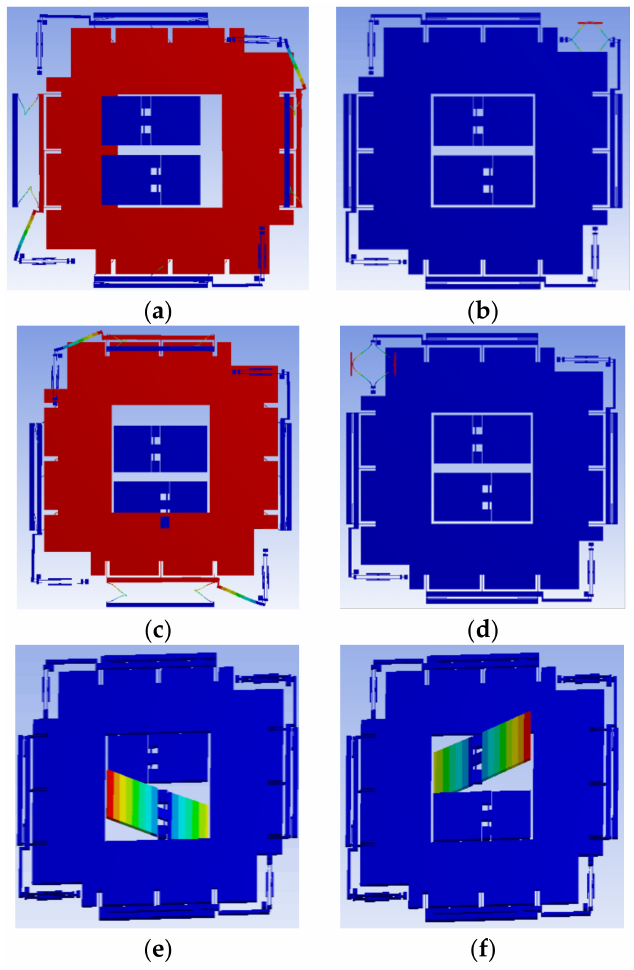
Figure 3. Vibration modal simulation of three-axis acceleration. ( a ) 1 kHz vibration of the mass in the x-axis; ( b ) 20 kHz vibration of a resonator in the x-axis; ( c ) 1 kHz vibration of the mass in the y-axis; ( d ) 20 kHz vibration of a resonator in the y-axis; ( e ) 1 kHz vibration of one seesaw in the z-axis; ( f ) 1 kHz vibration of another seesaw in the